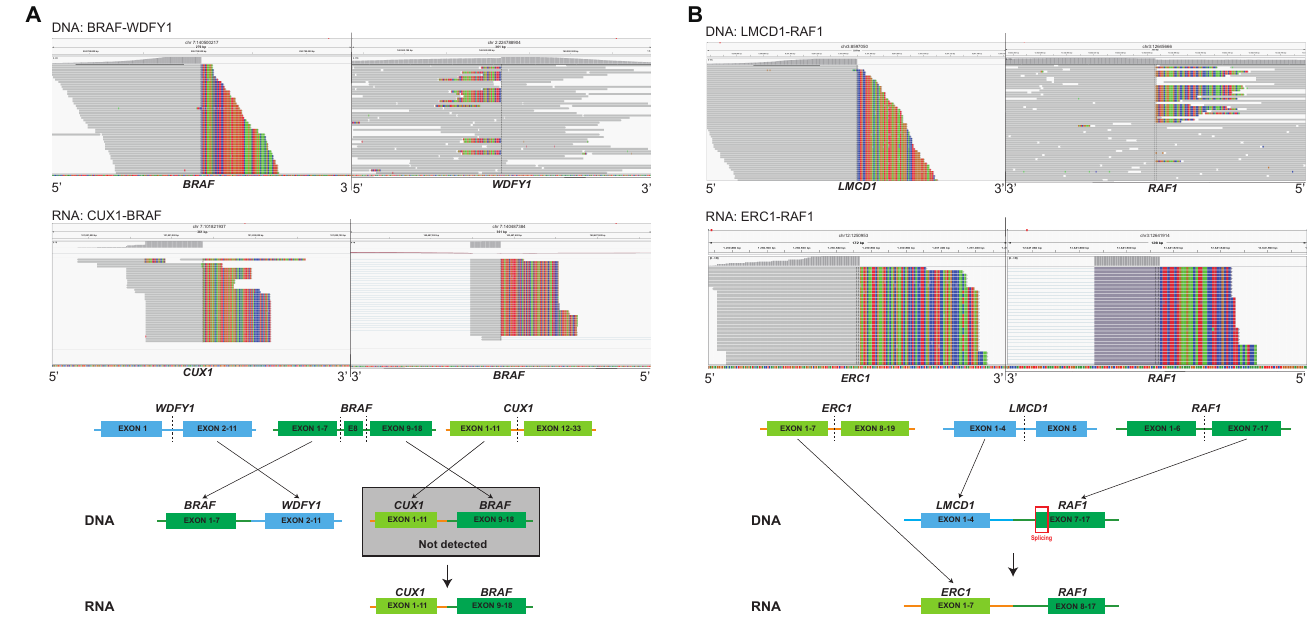
Figure 4. RNA sequencing can identify and correct the putative fusion transcripts of DNA sequencing. ( A ) BRAF fusion identified by both DNA-seq and RNA-seq; and ( B ) RAF1 fusion identified by both DNA-seq and RNA-seq.